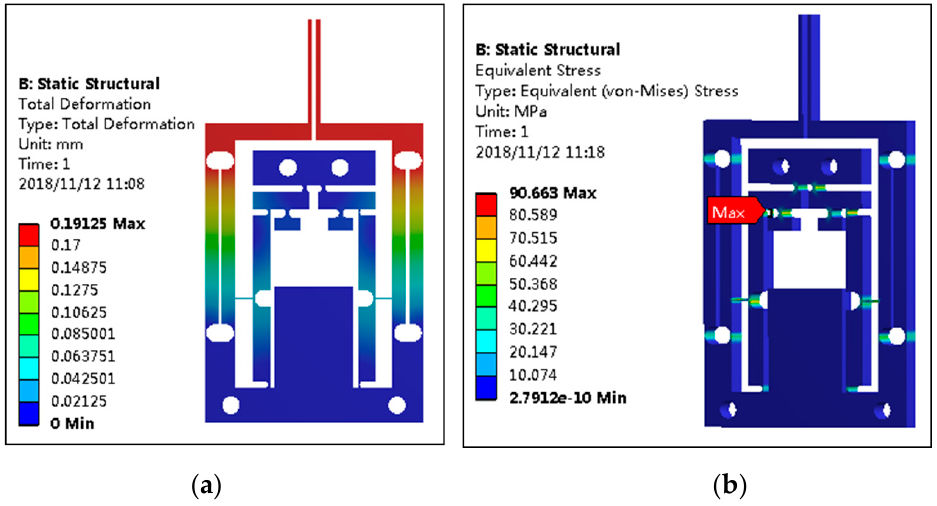
Figure 4. The displacement cloud diagram and stress cloud diagram of the microgripper. ( a ) The displacement cloud diagram; ( b ) the stress cloud diagram. In order to verify the translational gripping e ff ect of the microgripper, a 10 µ m input displacement was imposed on the microgripper. The output displacement of the left gripping jaw of the microgripper increases gradually from the tip to bottom. The maximum output displacement was 191.25 µ m at the bottom of the gripping jaw and the minimum 190.82 µ m at the tip. The translational error produced by the left gripping jaw is only 0.43 µ m, which indicated that the microgripper has fine translational performance, and can achieve the translational gripping of the operating object. Figure 5 shows the displacement cloud diagram of the left gripping jaw of the